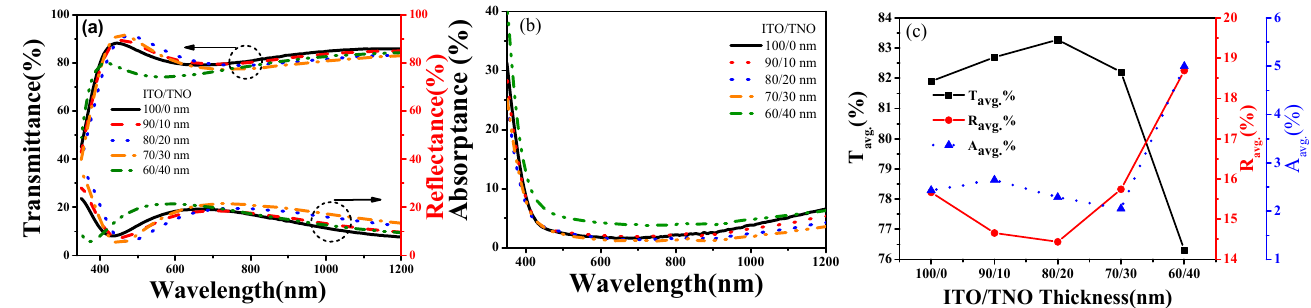
Figure 6. ( a ) Experimental transmittance and reflectance spectra of double-layer ITO/TNO with different thickness combinations on the glass substrates as a function of wavelength; ( b ) corresponding absorptance spectra; ( c ) corresponding average transmittance, reflectance, and absorptance in the wavelength range of 400–800 nm.